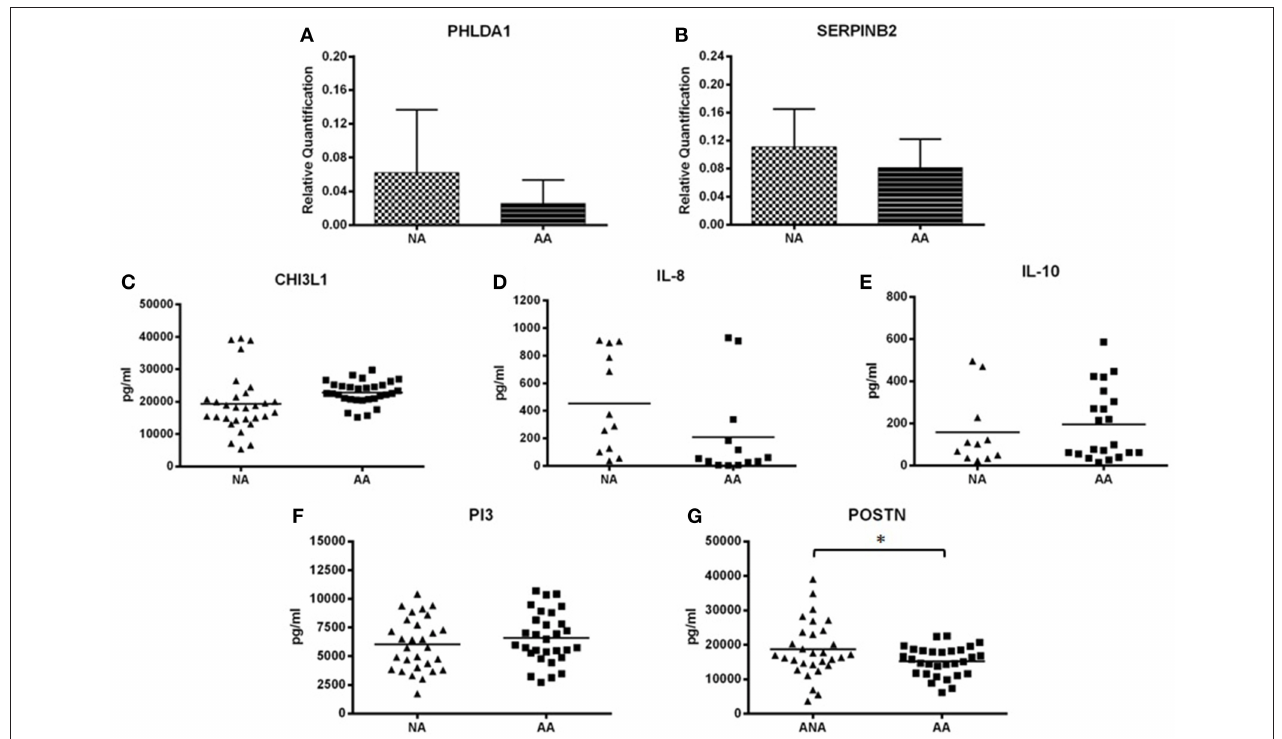
FIGURE 1 | Mean levels of protein expression. (A) Mean levels of PHLDA1. (B) Mean levels of SERPINB2. (C) Mean levels of CHI3L1. (D) Mean levels of IL-8. (E) Mean levels of IL-10. (F) Mean levels of PI3. (G) Mean levels of POSTN. *Statistically significant comparison ( P < 0.05) between the indicated groups. Protein levels of PHLDA1 and SERPINB2 were measured by Western blot in 5 NA and 6 AA subjects, and 11 NA and 11 AA, respectively. Densitometric analysis was done in individual blots (see “Materials and Methods”) using the β -actin protein for normalization. CHI3L1, IL-8, IL-10, PI3, and POSTN were quantified by ELISA in all patients included in the study population. The levels and relative expression of the proteins studied were compared among groups by unpaired t -test, using the Graph-Pad InStat 3 program. The error bars indicate the standard deviation. NA, total nonallergic asthma group; AA, total allergic asthma